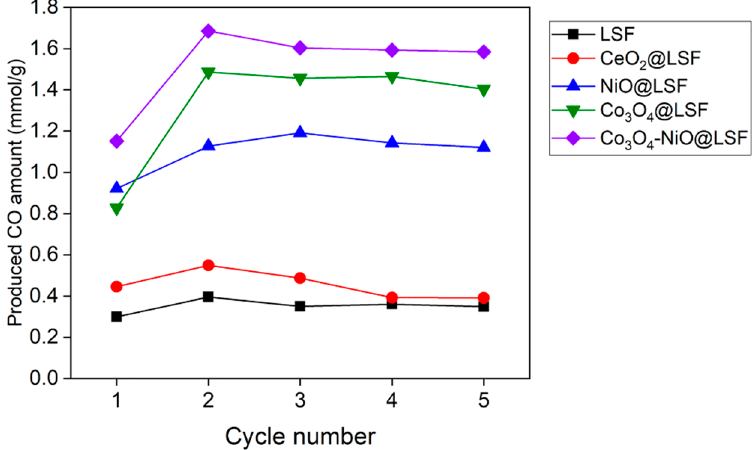
Figure 5. Amounts of CO produced by the oxygen carriers during the oxidation step.